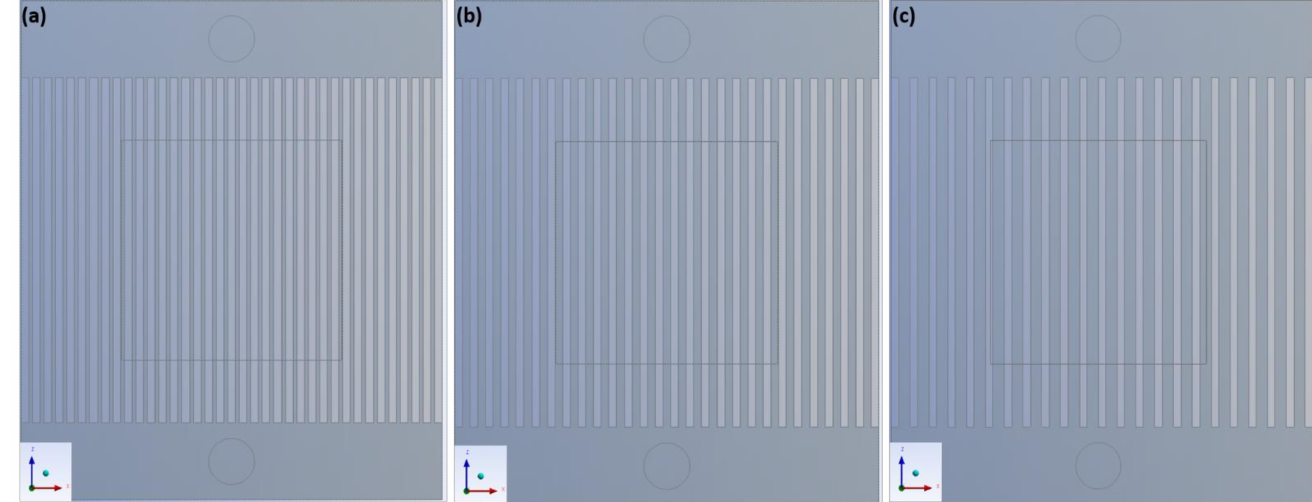
Figure 5. SIFMCHSs: ( a ) 0.5 mm, ( b ) 1 mm, and ( c ) 1.5 mm fin spacing.